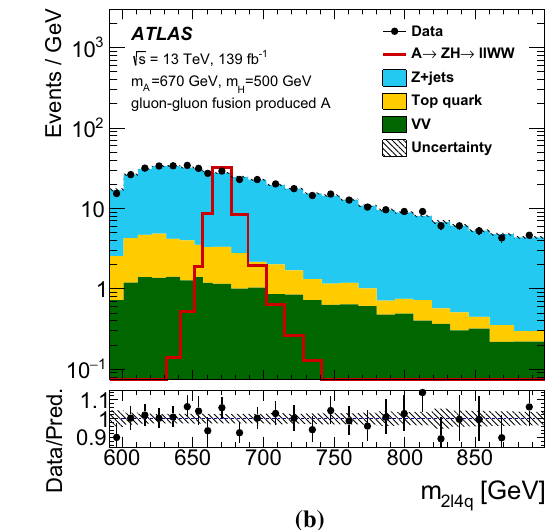
( 670 , 500 ) GeV. The number of entries shown in each bin is the num- ber of events in that bin divided by the width of the bin. The same conventions as in Fig. 4 are used